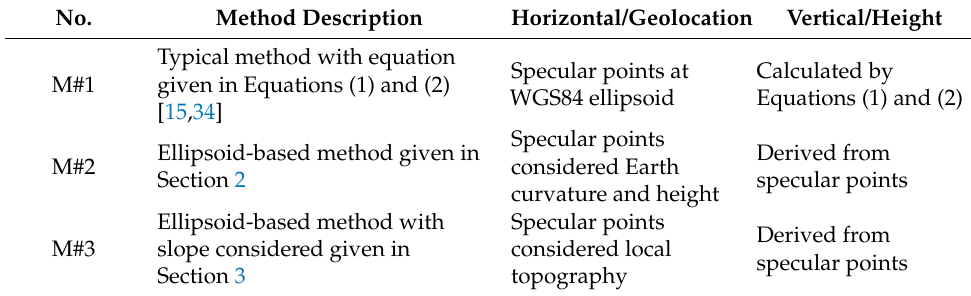
Table 2. Details of methods in the comparison.